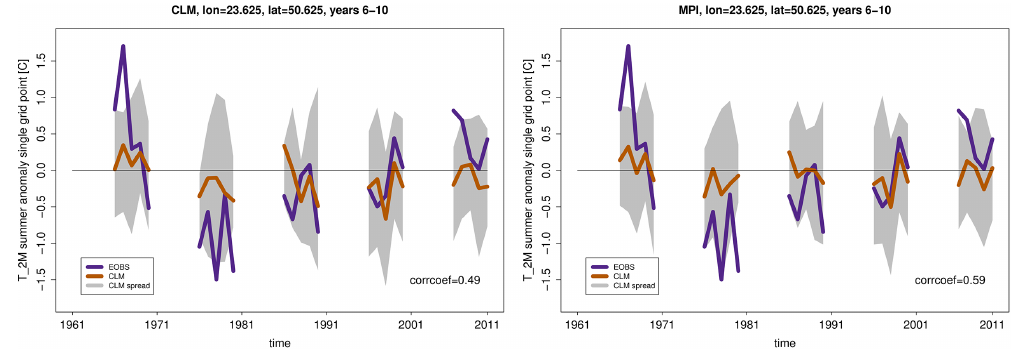
Figure 12. Summer temperature anomalies in South-East Poland. Shown are lead years